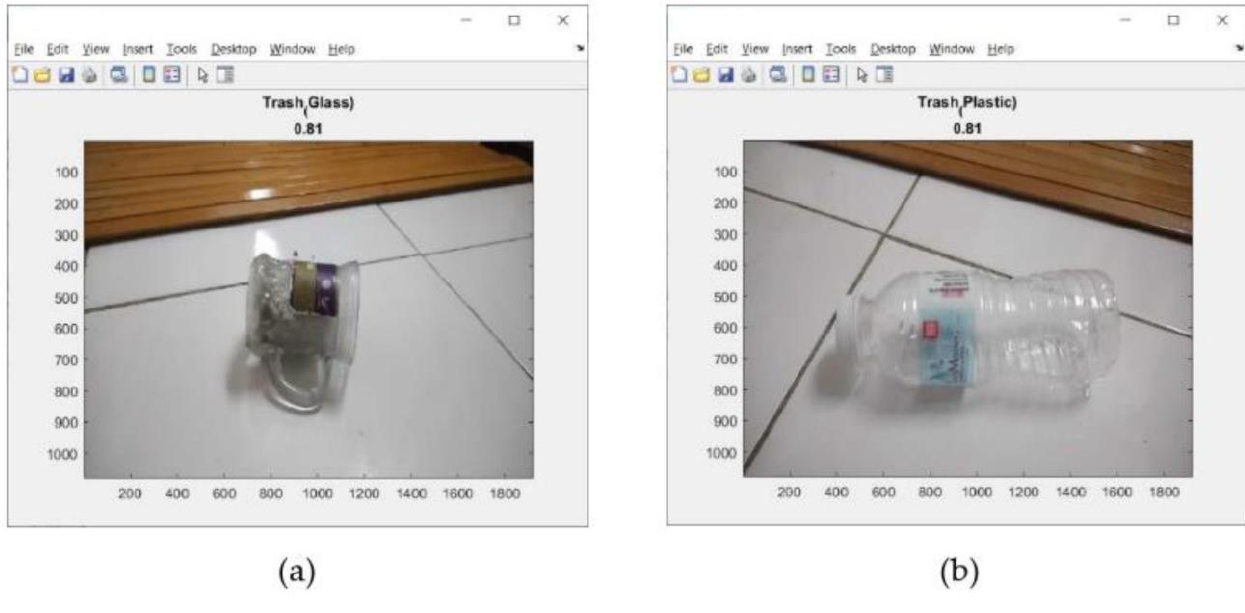
Figure 21. Results of trash identification using a real-time camera. ( a ) glass; ( b ) plastic.